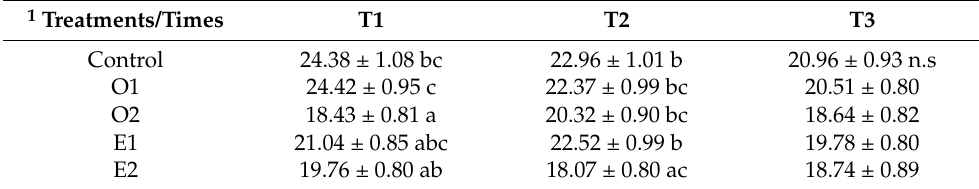
Table 2. Total phenolic content mg g − 1 in the extracts of Tanacetum balsamita L. plants from different treatments and times. At T0 the average value for all the plants was 18.91 ± 0.83 mg g − 1